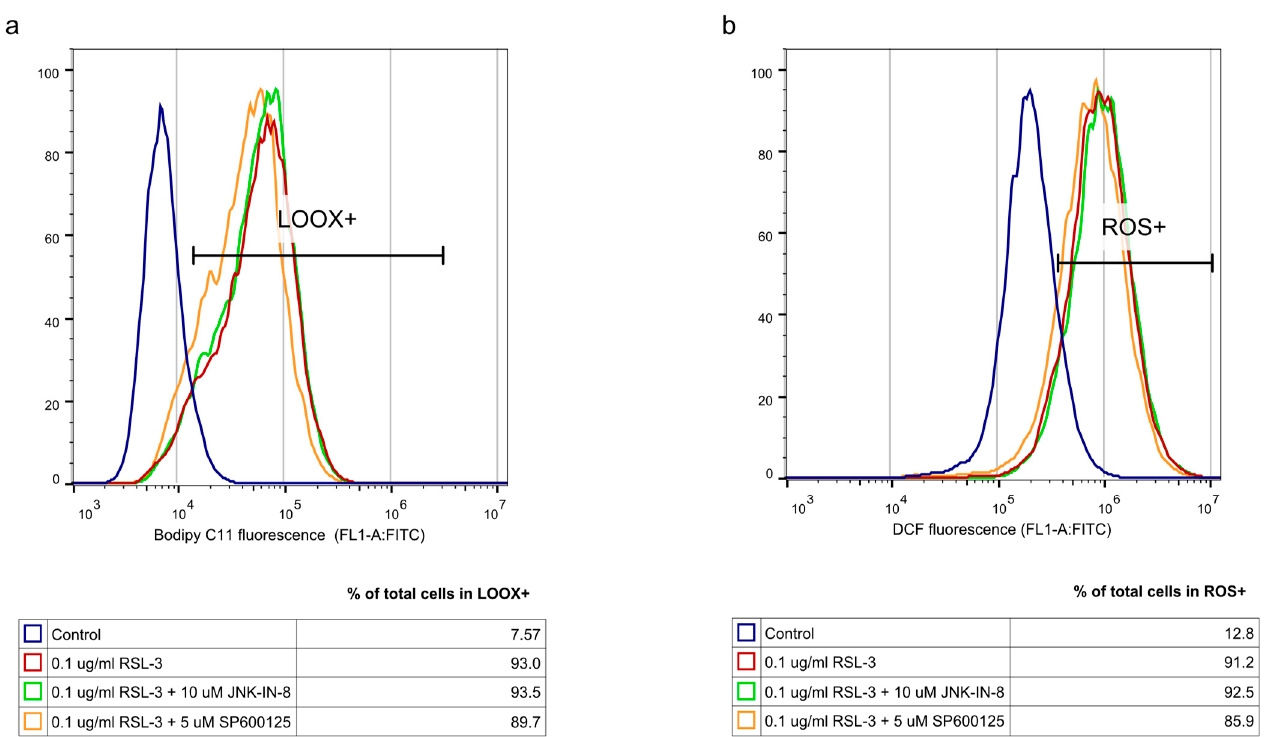
Figure 4. Pharmacological inhibition of JNK activity does not affect the oxidative aspects of RSL-3- induced ferroptosis. HT-1080 cells were treated on a 24-well plate for 2 h with the ferroptosis-inducing compound, RSL-3 (0.1 µg/mL), in the presence or absence of the JNK inhibitors, JNK-IN-8 (10 µM) or SP600125 (5 µM). RSL-3 treatment causes oxidative stress through ( a ) lipid peroxidation (LOOX) and ( b ) ROS formation, but JNK inhibition does not affect either lipid peroxidation or ROS formation. Cells were prepared, stained, and measured with a flow cytometer, as described above, using a Bodipy C11 fluorescent probe for lipid peroxidation and a DCF fluorescent probe for ROS measurement. Control samples were fluorescent-labelled but untreated. One representative experiment is shown. Cell population was gated using FSC-W for singlets and propidium iodide negative staining (living cells).